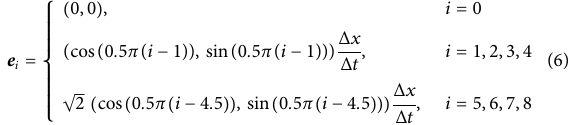
FIGURE 4 Architecture of the